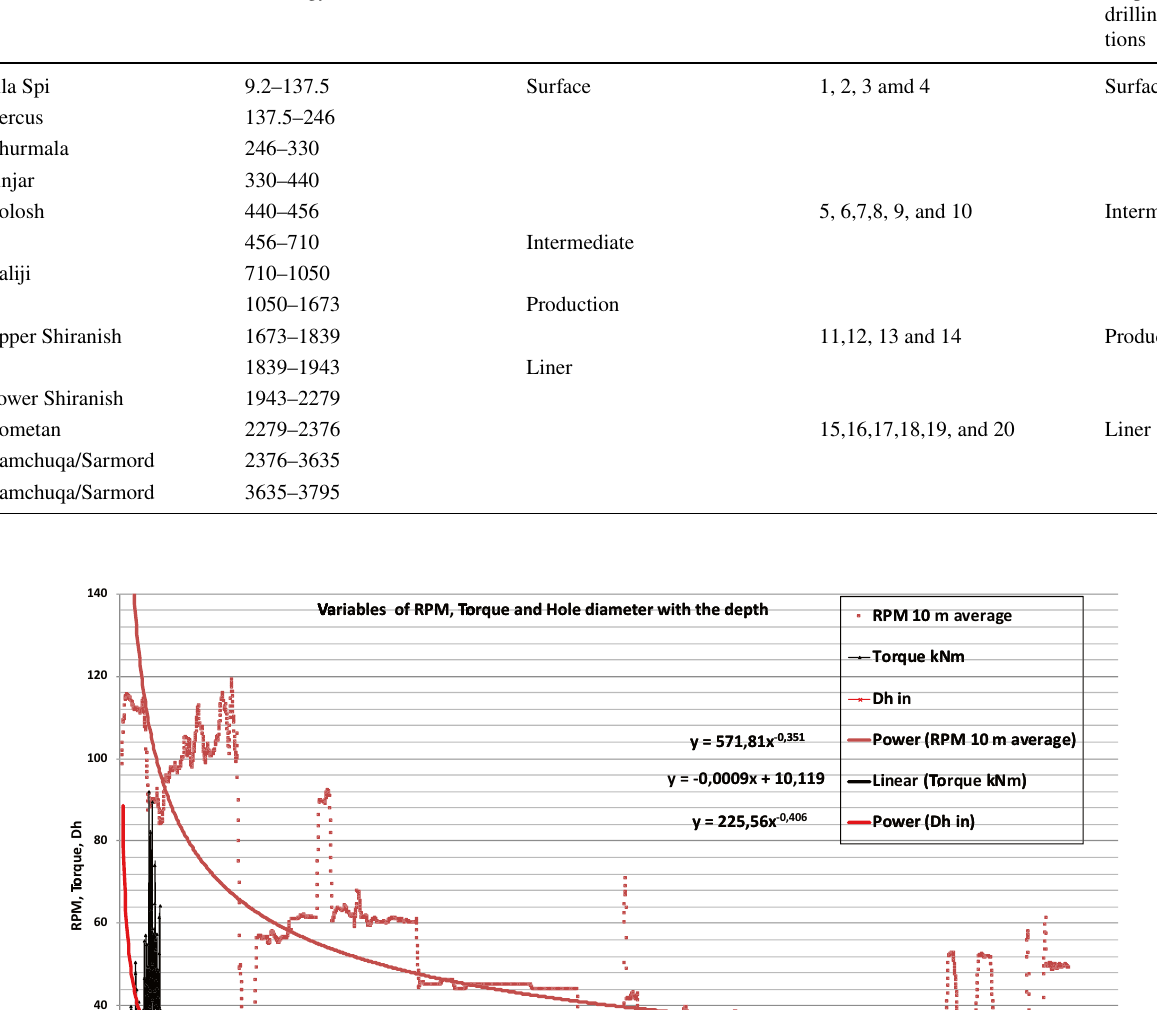
Table 5 Proposed drilling sections in more harmonic situations Formations Lithology Interval (m) Sections drilled in Bn-1